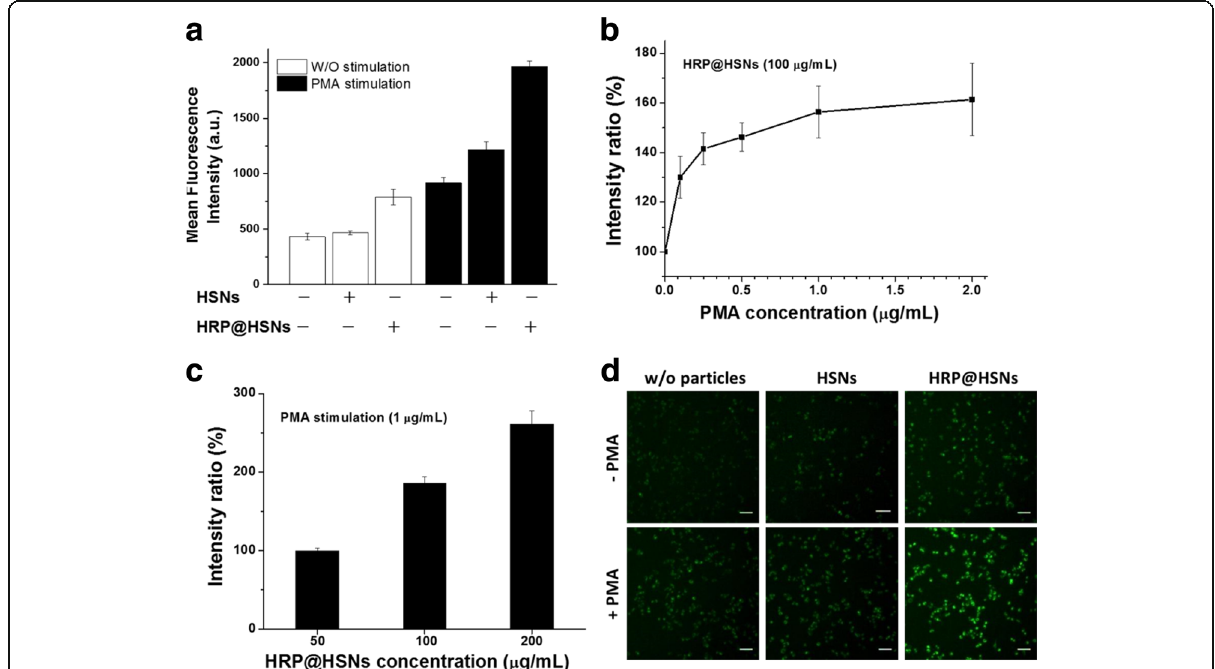
Fig. 3 a Flow cytometry analyses of RAW264.7 macrophages stimulated with and without phorbol 12-myristate 13-acetate (PMA) in the presence and absence of nanoparticles. b PMA and c horseradish peroxidase-encapsulated HSNs (HRP@HSNs) concentration dependently altered the fluorescence of RAW264.7 macrophages. d The representative fluorescence images of RAW264.7 macrophages at the indicated conditions. Scale bars 50 μ